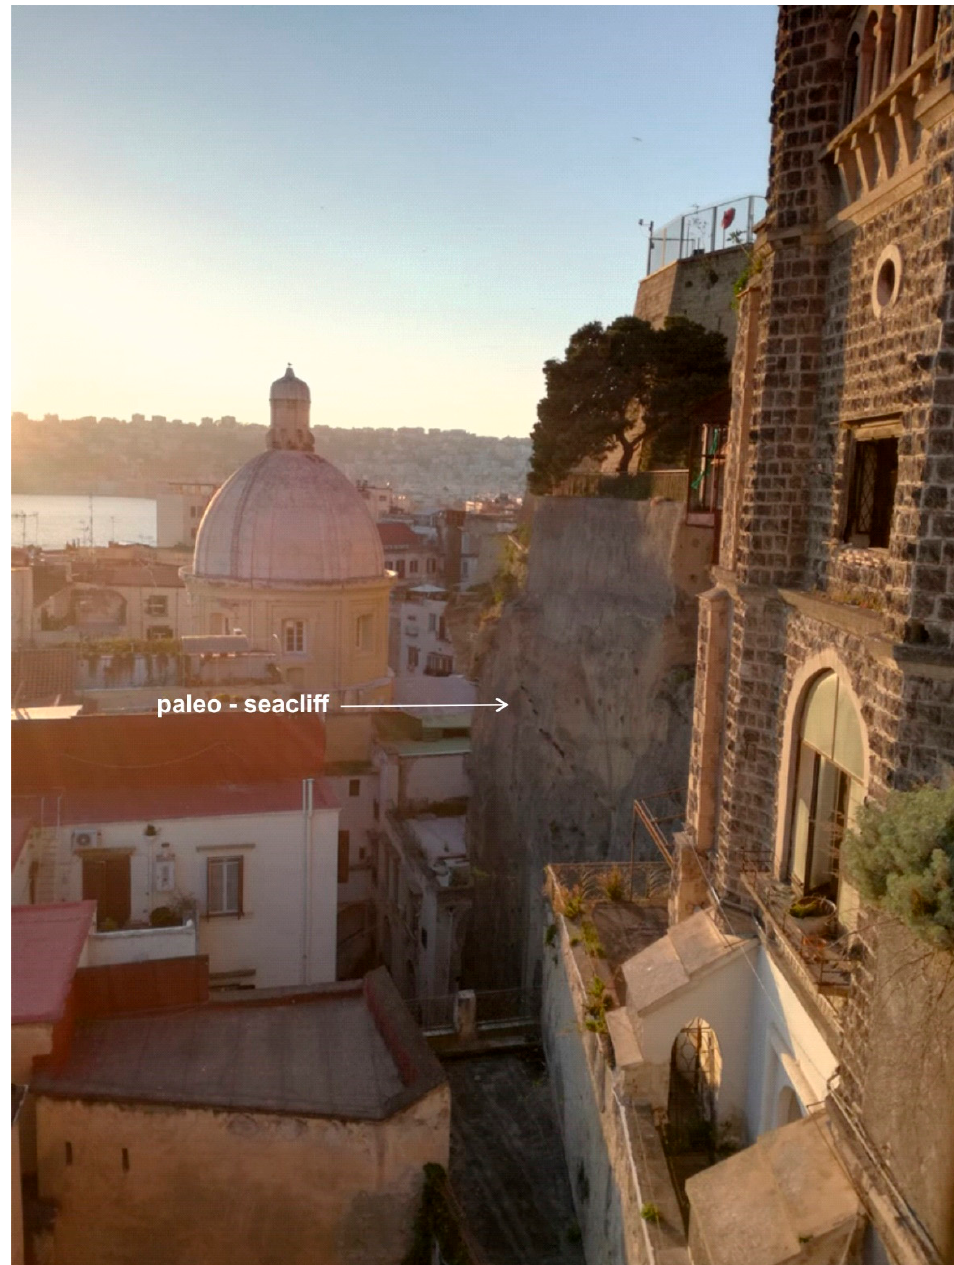
Figure 8. Pizzofalcone promontory. The highest reach of the paleo-sea cliff marking the inner margin of the cliff is cut and disappears under retaining walls and buildings (photo taken by the authors during the surveys).